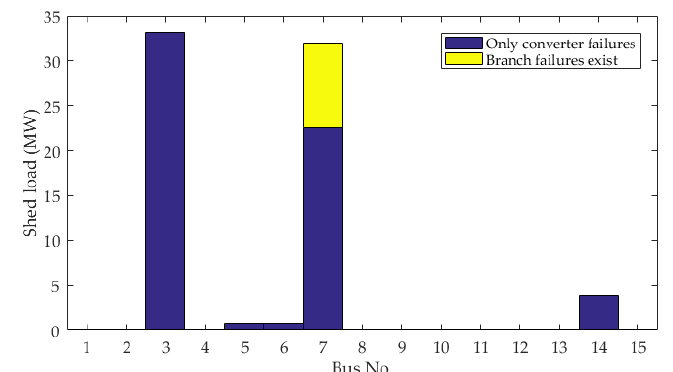
Figure 9. Histogram of shedding value.